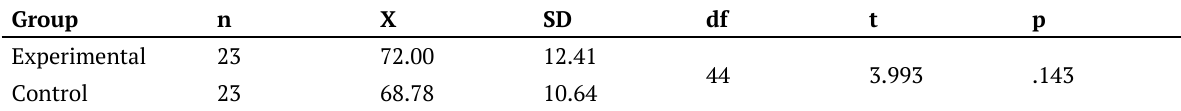
Table 3. Differences between experimental and control groups regarding post-test scores of self-esteem Group Experimental